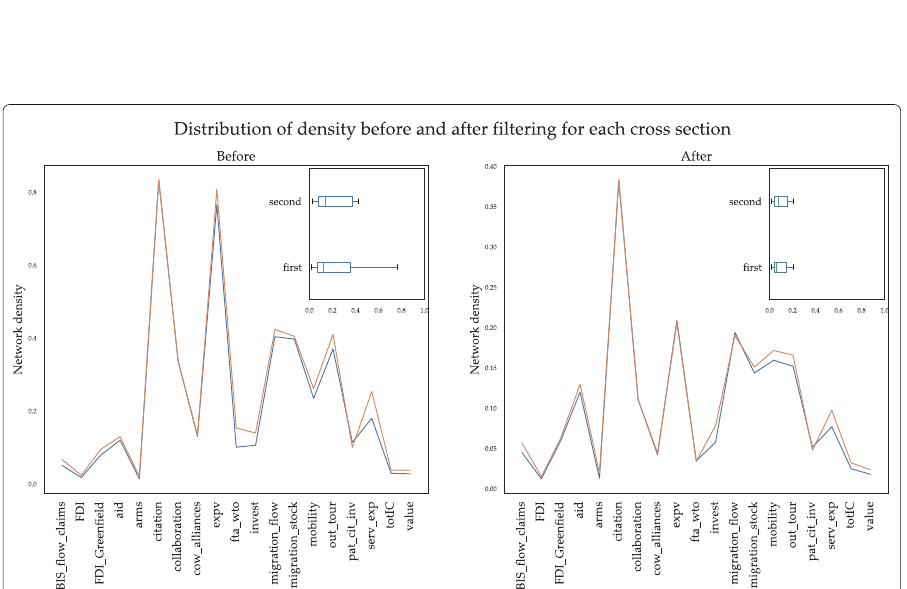
Fig. 15 How density of layers has changed: before the filter (left panel) and after (right panel). Cross section in 2003 in blue, cross section in 2010 in red. On the inset panels boxplots of the density values of the two cross